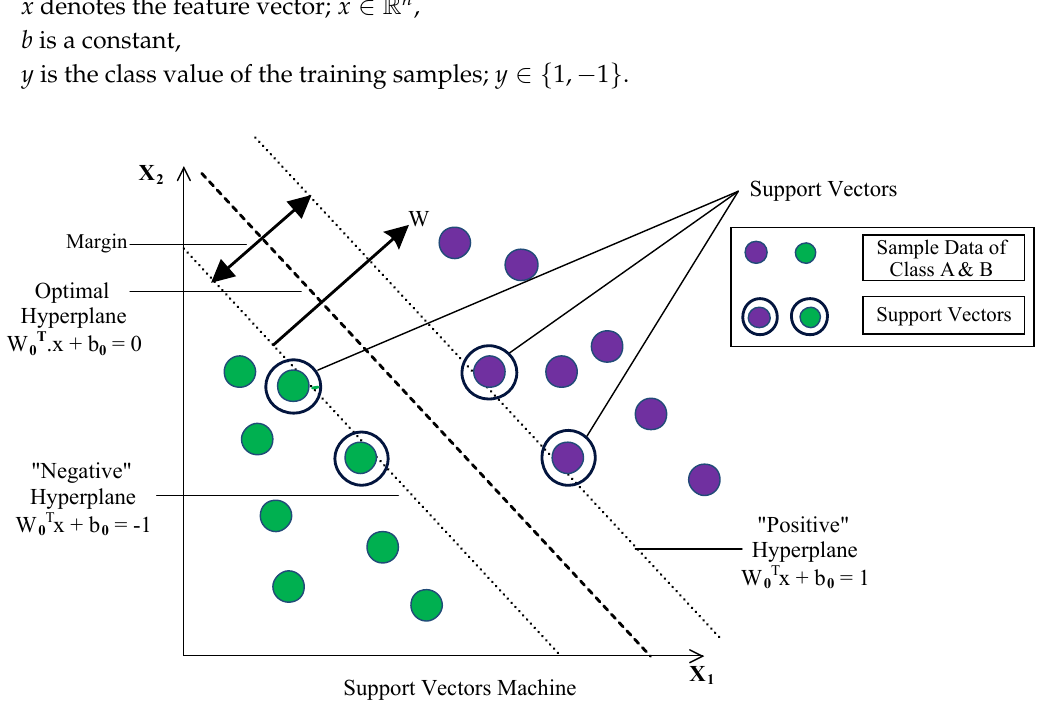
Figure 2. Support Vector Machine: